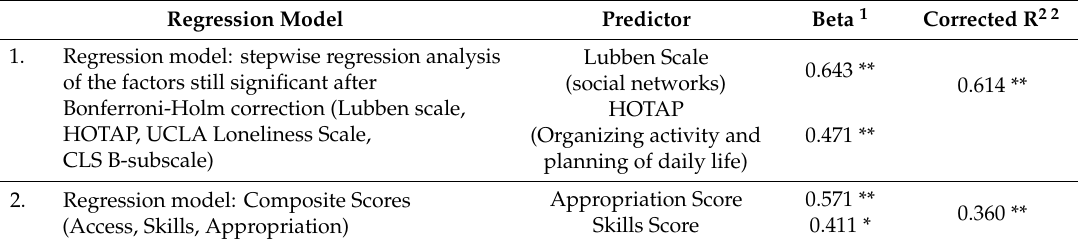
Table 5. Regression models LSA.